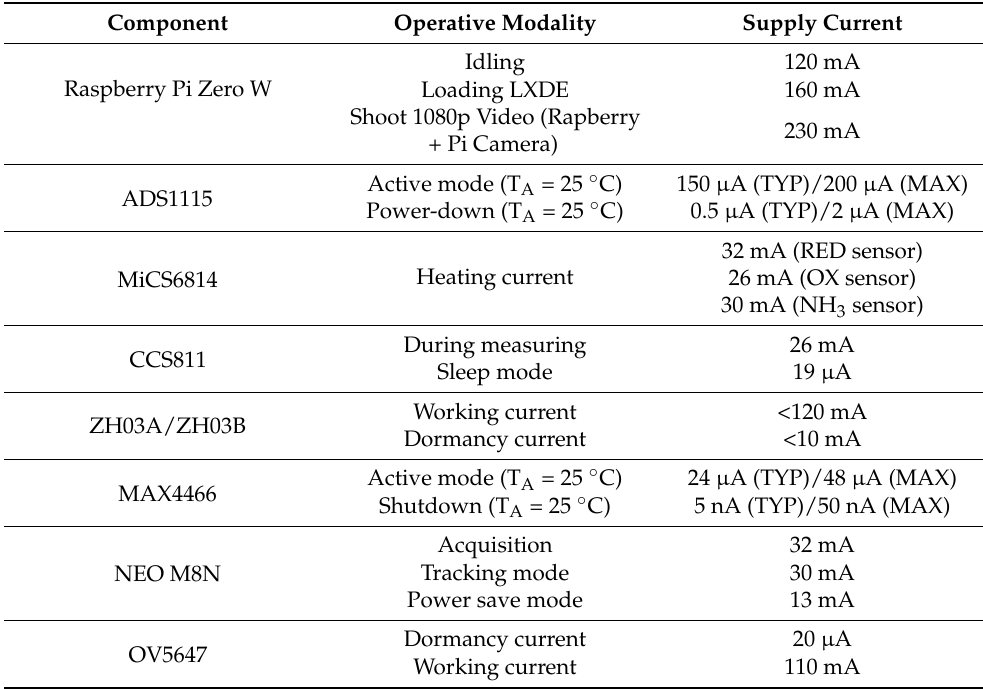
Table 2. Summarizing table with supply current values of the different components included in the developed mobile sensor